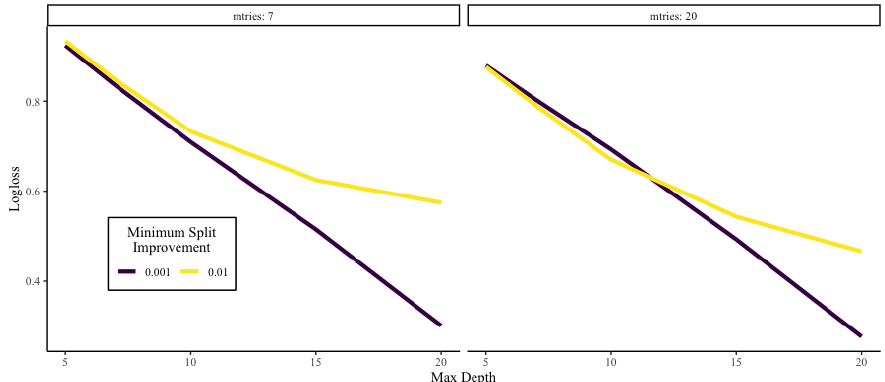
Figure 2. Visualization of the results from tuning random forests to predict claim frequency on the BI data. Here, we show the change in logloss across different values of max depth of each tree in the random forest. The left pane shows the results when mtry is 7, and the right pane shows the results when mtry is 20. Each pane contains two lines of different colors representing different minimum split